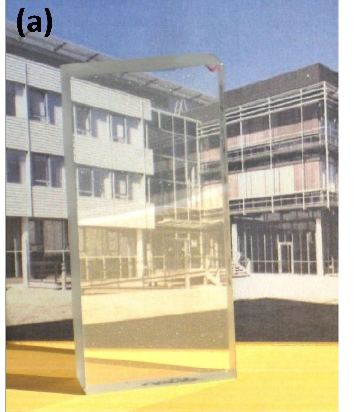
Figure 14. Transparent armor nano-ceramics; ( a ) MgAl 2 O 4 transparent nano-ceramics, 12 mm thick, created through pre-sintering in air and HIP methods [83]. Reprinted with permission from Ref. [83]. Copyright 2014, copyright ScienceDi rect . ( b ) a photograph revealing the transmittance of the Mg- γ -AlON transparent ceramic after HIP treatment [96]. Reprinted with permission from Ref. [96]. Copyright 2019, copyright ScienceDi rect .